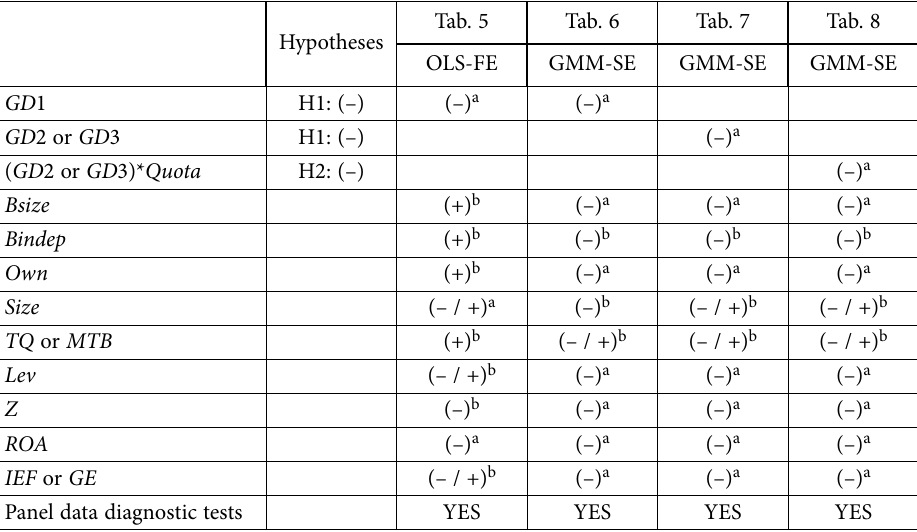
Table 9. Summary of regression